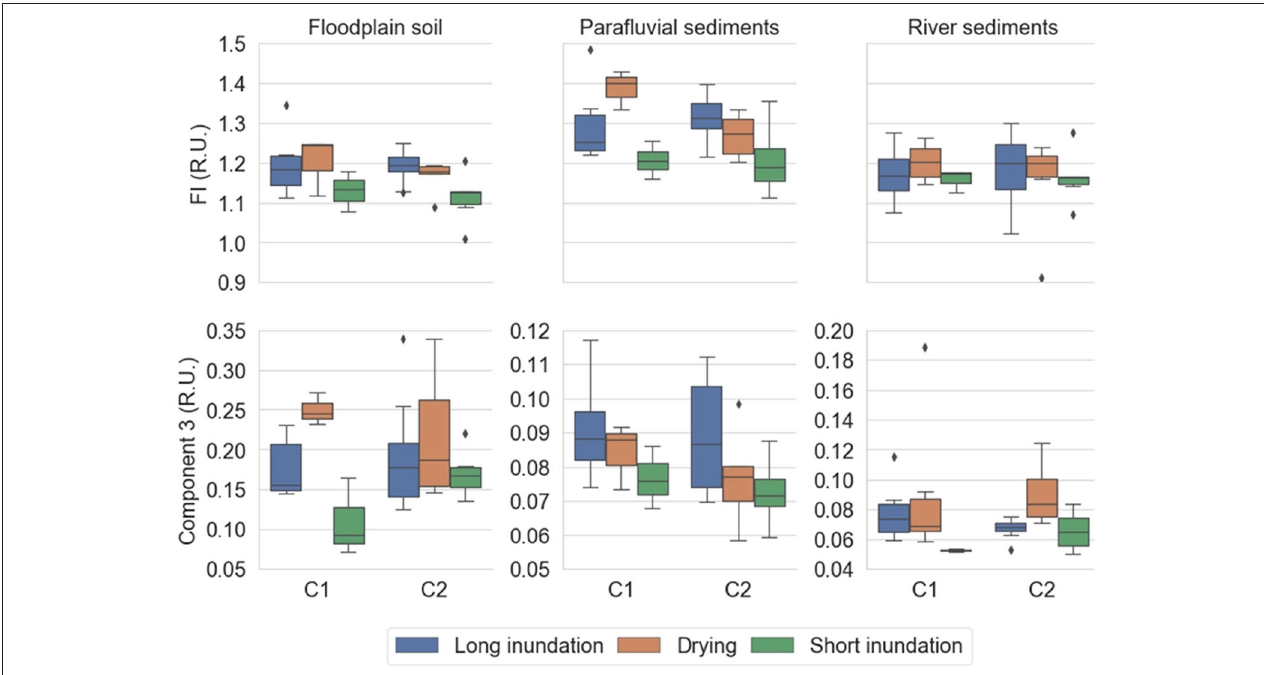
FIGURE 5 | FI and PARAFAC component 3 from soil and sediment extracts per site (floodplain soil, parafluvial sediments, river sediments) for each phase (long inundation, drying phase, short inundation phase). The data is aggregated by cycle (cycle 1 and 2). For each cycle, the treatment cores were subject to drying (orange; n = 6) and short inundation (green; n = 6) events. The control cores (blue; n = 12) were kept flooded throughout the entire experiment and were equally sampled at the same dates as the treatment cores. Error bars are the 95% confidence interval, the bottom and top of the box are the 25th and 75th percentiles, the line inside the box is the 50th percentile (median), and any outliers are shown as